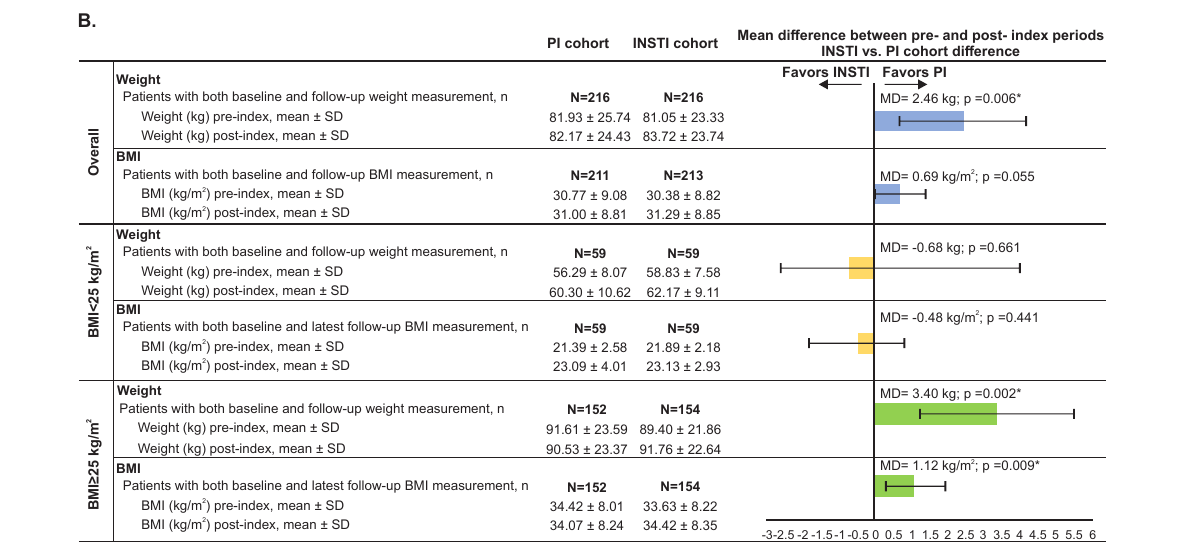
Figure 2A indicates mean change in weight for all patients; among patients with baseline BMI ≥25 kg/m 2 , those with BMI ≥5% increases were 28.9% vs. 19.5% for INSTI and PI, respectively; OR=1.68; 95% CI [1.25-2.27]. Among patients with baseline BMI <25 kg/m 2 , those with BMI ≥5% increases were 40.1% vs. 36.1% for INSTI and PI, respectively; OR=1.19; 95% CI [0.86-1.64]. Figure 2B indicates mean change in weight for females only. For Figure 2B, the mean differences are calculated from adjusted values. * indicates P <